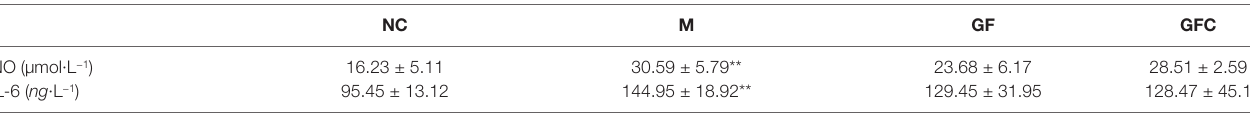
TABLE 1 | Effect of Gardenia Fructus (GF) and carbonized GF (GFC) on the level of nitric oxide (NO) and interleukin 6 (IL-6) in the serum of rats in the ethanol-induced acute gastric ulceration model.